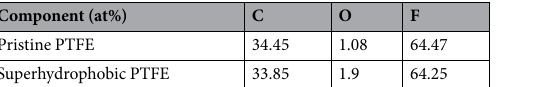
Table 1. Elemental composition of the pristine and plasma-treated superhydrophobic PTFE sheets from XPS broad spectra.